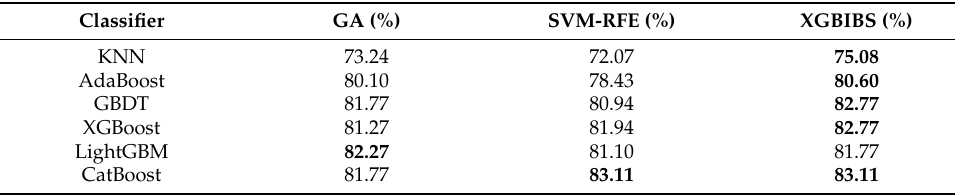
Table 12. Performance of feature selection algorithms on classification accuracy.